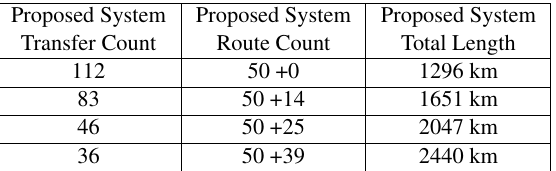
Table 6: Transfer and Length Comparison Proposed